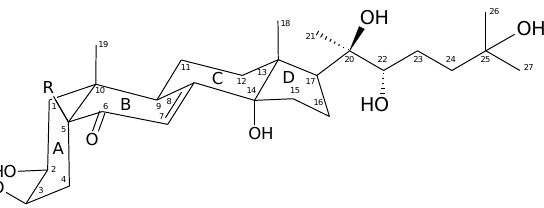
Figure 1. Chemical structure of 20-hydroxyecdysone (R=H, compound 1 ) and polypodine B (R=OH, compound 2 ), the major ecdysteroid constituents of Lychnis flos-cuculi. Table 1. NMR spectral data of compounds 1 and 2 (in CD 3 OD).